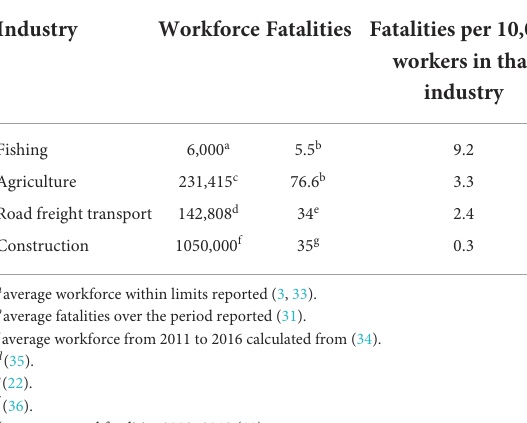
TABLE 4 Contextualized fatality rates per 10,000 workers.